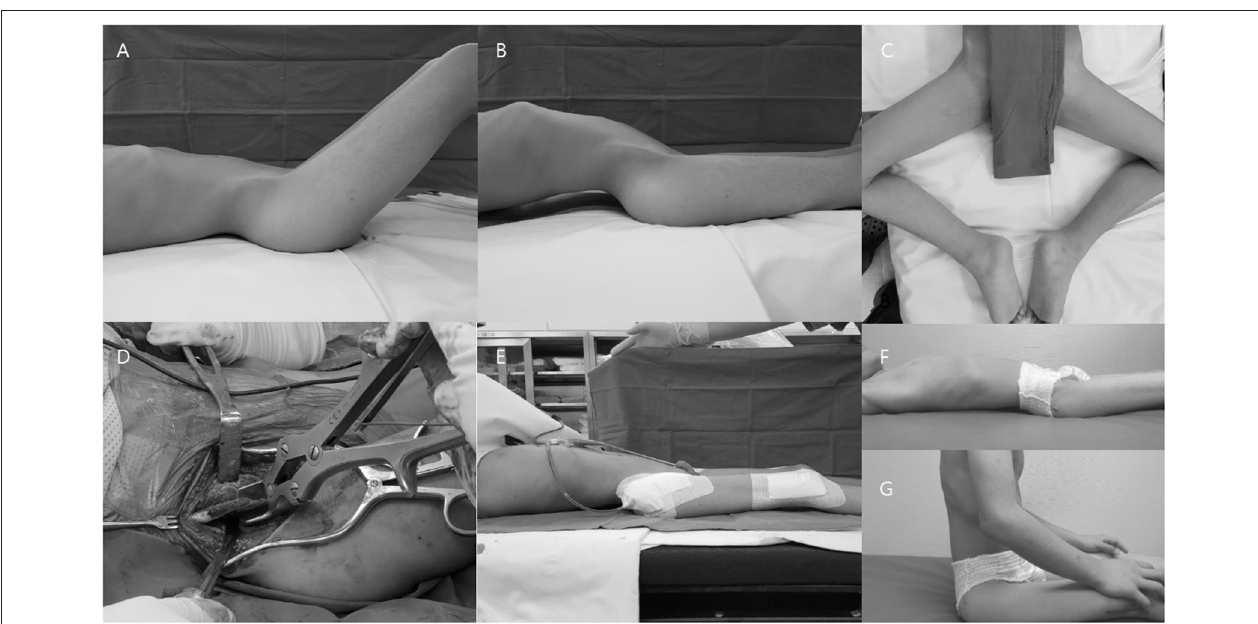
FIGURE 2 | Representative images of a patient who underwent proximal and distal extensive soft tissue release with an additional iliac crest ostectomy. (A) Hip flexion contracture. (B) Compensatory hyperlordosis. (C) Abduction and external rotation of the hip for comfort when lying. (D) Additional iliac crest ostectomy. (E) Disappearance of the lumbar hyperlordosis after surgery. (F,G) Patient experienced improved comfort when lying and sitting.